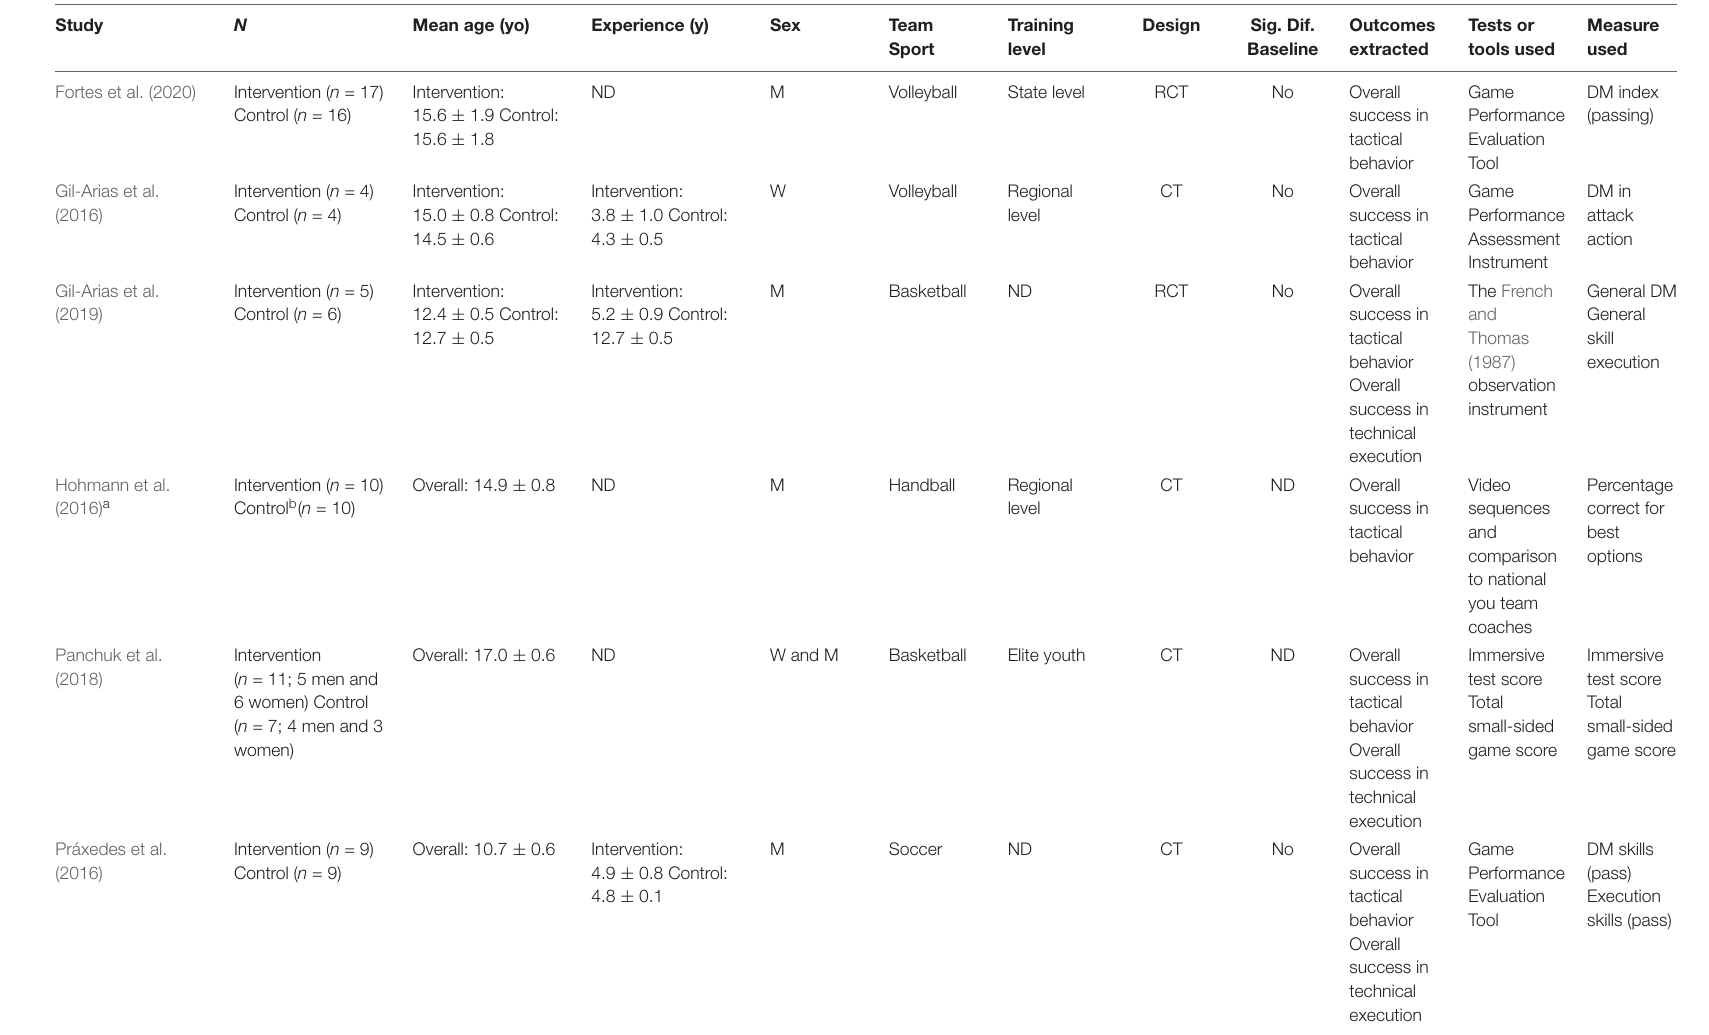
TABLE 2 | Characteristics of the included studies and outcomes extracted.